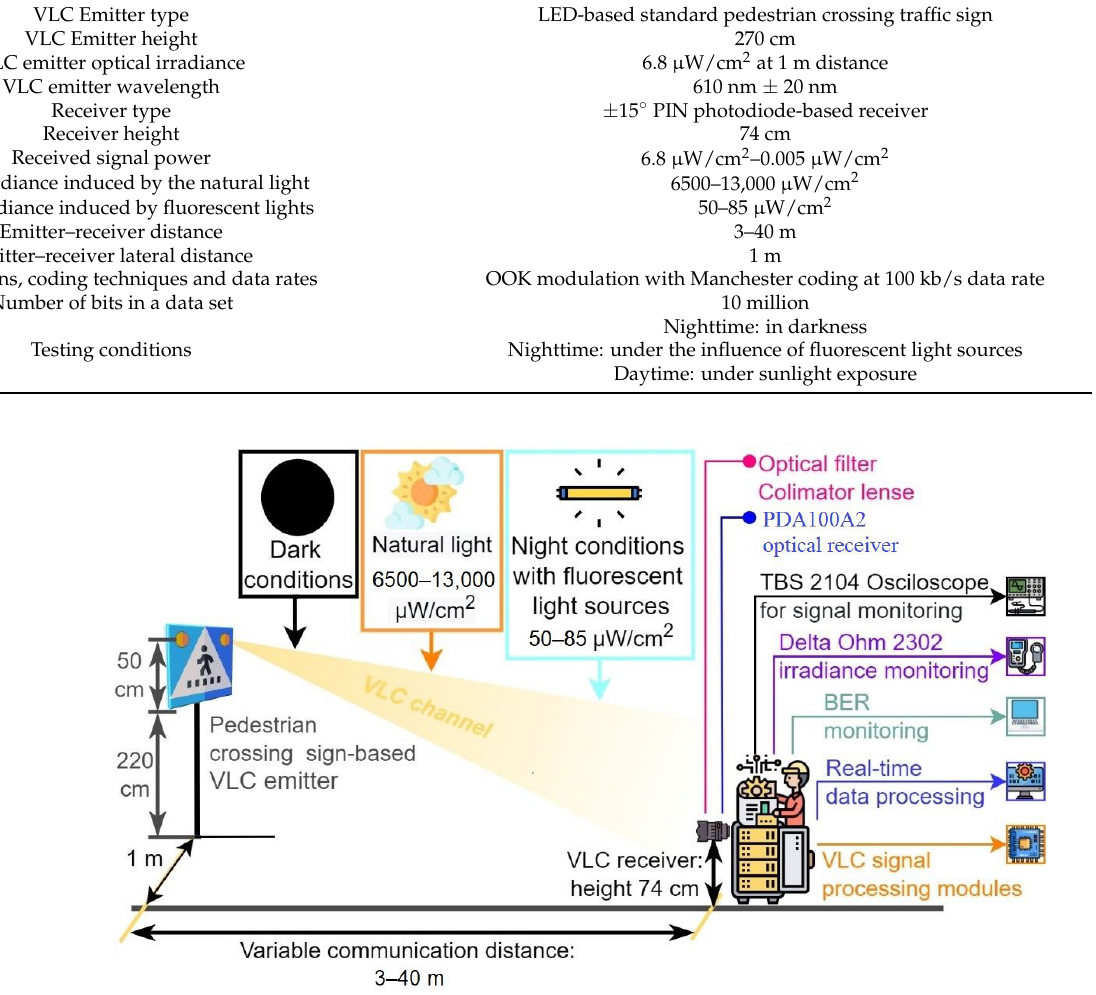
Figure 8. Schematic of the experimental setup.